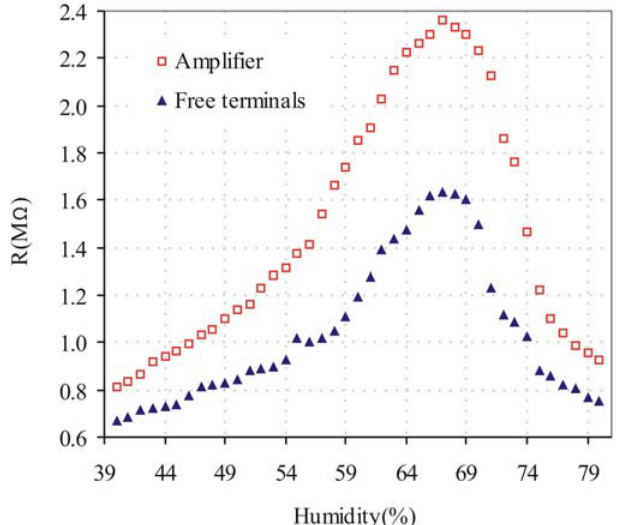
Figure 9. Effect of humidity over the resistance of SWCNTs detected by electrodes connected to the amplifier and free